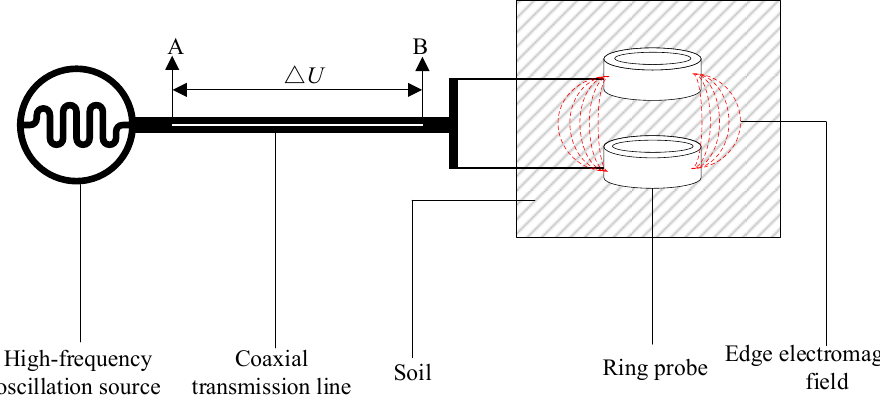
Figure 2. EEMFI sensor measurement schematic.